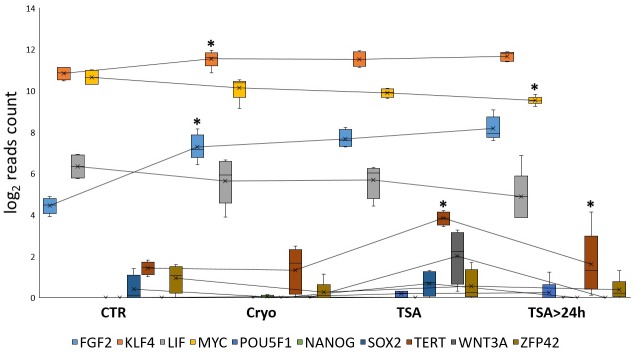
Changes in expression level of major pluripotency marker genes after cryopreservation, TSA administration and TSA removal.Significant differences in expression level on pointwise level are marked with asterisk.